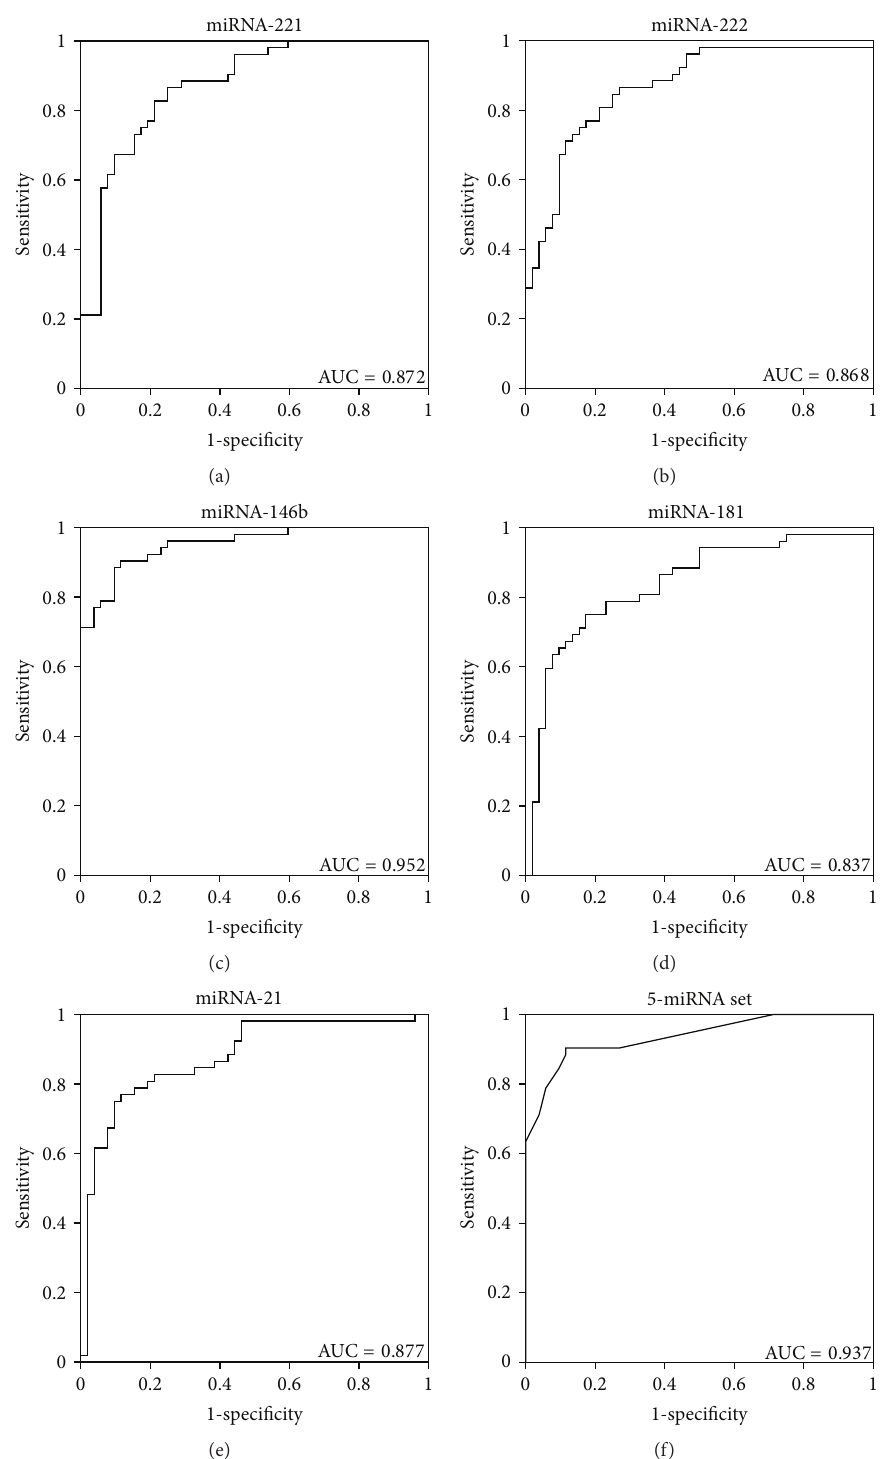
Figure 2: ROC curve analyses of miRNA-221 (a), miRNA-222 (b), miRNA-146b (c), miRNA-181 (d), miRNA-21 (e), and the 5-miRNA set (f) in the discrimination of patients with PTC from patients with BTN. The AUCs for miRNA-221, miRNA-222, miRNA-146b, miRNA-181, miRNA-21, and the 5-miRNA set were 0.872, 0.868, 0.952, 0.837, 0.877, and 0.937,